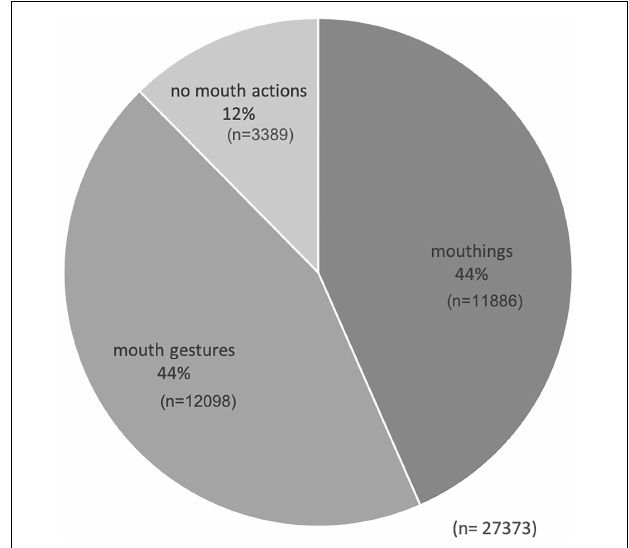
FIGURE 2 | Mouth actions in the RSL corpus.